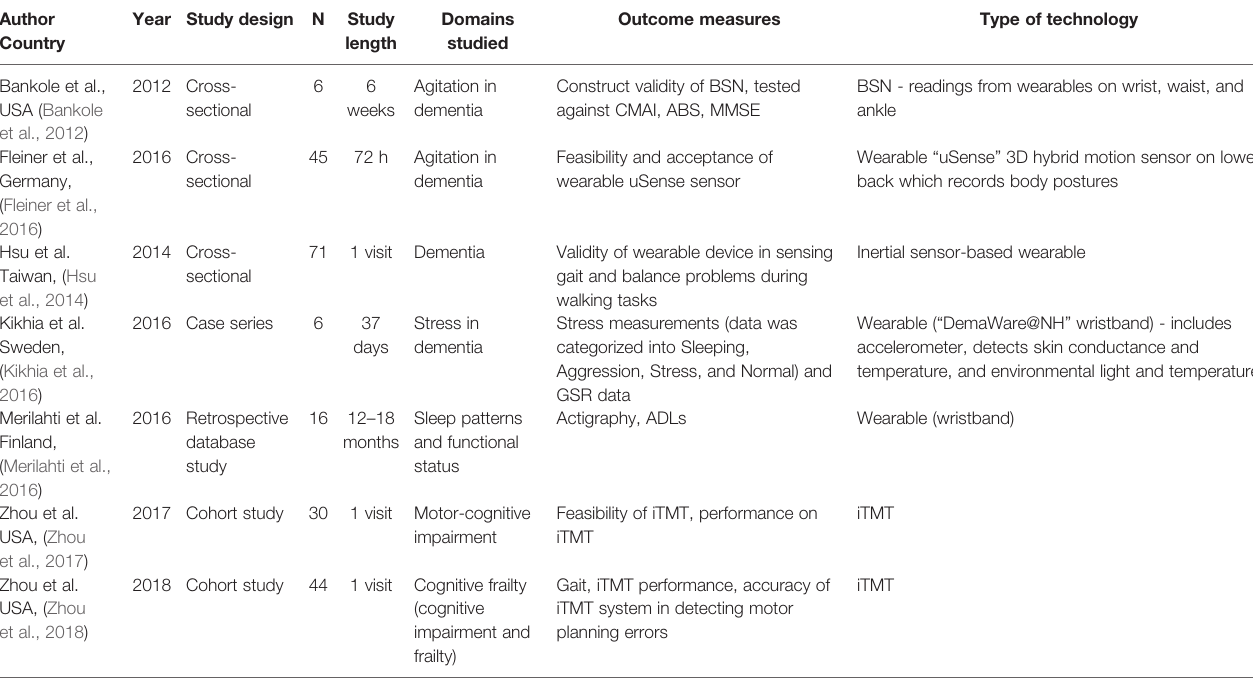
TABLE 2 | Studies utilizing wearable